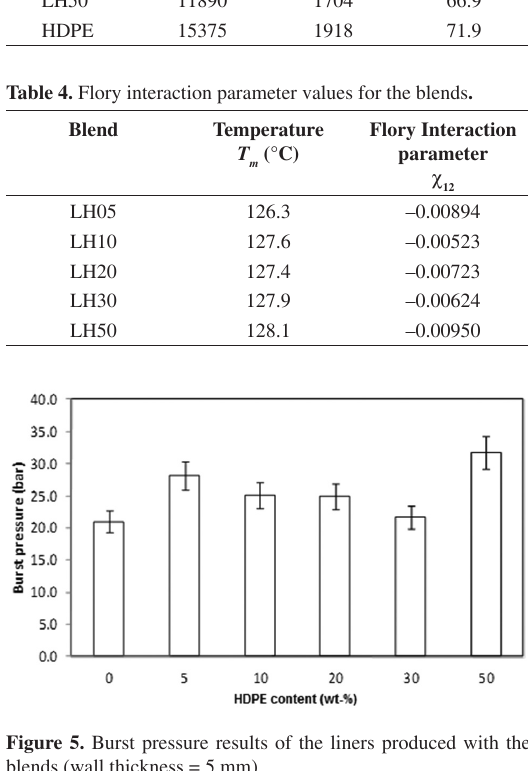
Figure 2. Variation of void content for the polymeric blends.